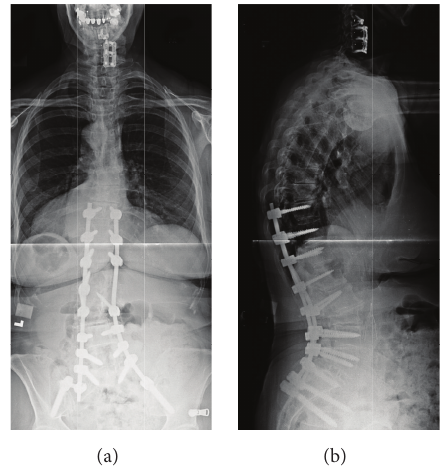
Figure 4: Posterior-anterior (a) and lateral (b) postoperative 3-foot scoliosis X-rays. Note the markedly improved coronal and sagittal balance achieved after the deformity